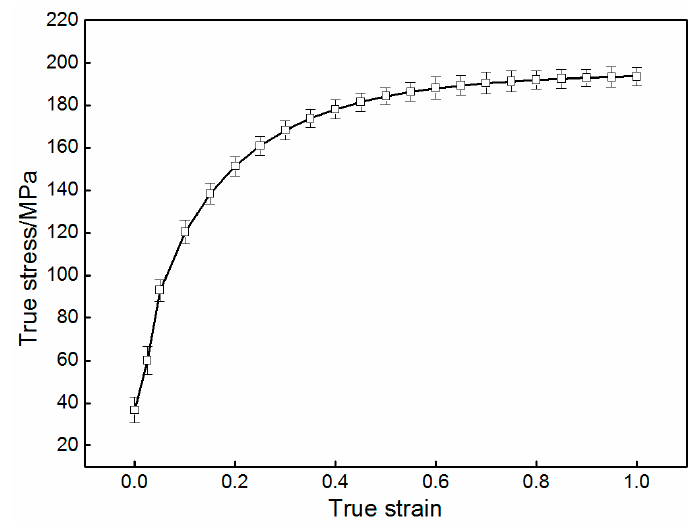
Figure 8. Improved rolls-strip coupling model based on FE-IE coupling method.